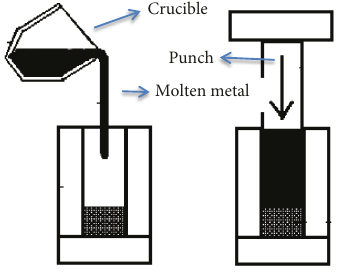
Figure 2: Squeeze casting